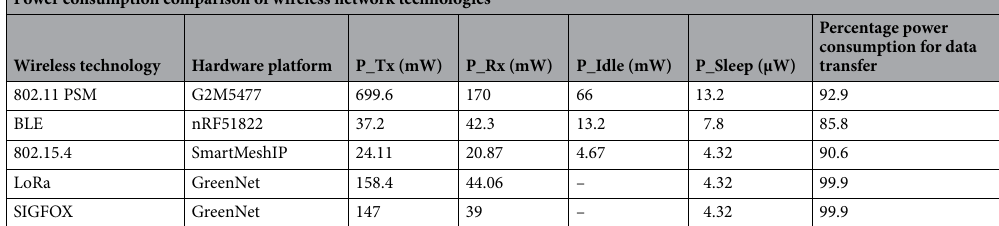
Table 1. Power consumption of various network technologies (assuming all the states are equally likely; for high data rate, the likelihood of sensor node being in Tx or Rx would be greater than the other states resulting in an even higher percentage power consumption for data